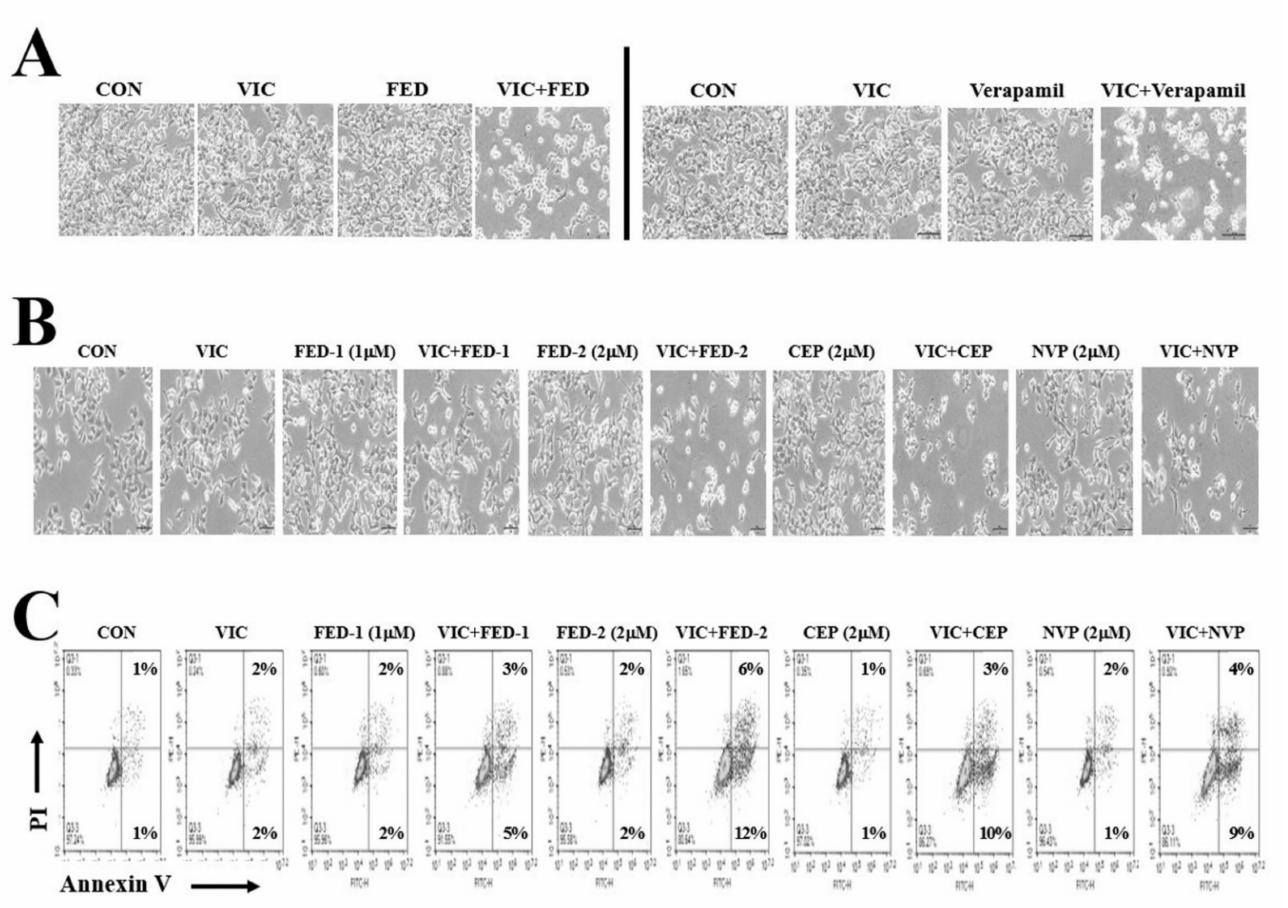
Figure 4. JAK2 inhibitors (fedratinib, CEP-33779, and NVP-BSK805) sensitize VIC-treated KBV20C cells via similar mechanisms of action. ( A ) KBV20C cells were plated on 60 mm diameter dishes and treated with 5 nM vincristine (VIC), 2 µ M fedratinib (FED), 10 µ M verapamil, 5 nM VIC with 2 µ M fedratinib (VIC + FED), 5 nM VIC with 10 µ M verapamil (VIC+VER), or 0.1% DMSO (CON). After 1 day, all cells were observed using an inverted microscope at × 100 magnification. ( B , C ) KBV20C cells were plated on 60 mm diameter dishes and treated with 5 nM vincristine (VIC), 1 µ M fedratinib (FED-1), 2 µ M fedratinib (FED-2), 2 µ M CEP-33779 (CEP), 2 µ M NVP-BSK805 (NVP), 5 nM VIC with 1 µ M fedratinib (VIC + FED-1), 5 nM VIC with 2 µ M fedratinib (VIC + FED-2), 5 nM VIC with 2 µ M CEP-33779 (VIC + CEP), 5 nM VIC with 2 µ M NVP-BSK805 (VIC + NVP), or 0.1% DMSO (CON). After 24 h, microscopic observation at x100 magnification ( B ) or annexin V analyses ( C ) were performed as described in Section 4, Materials and